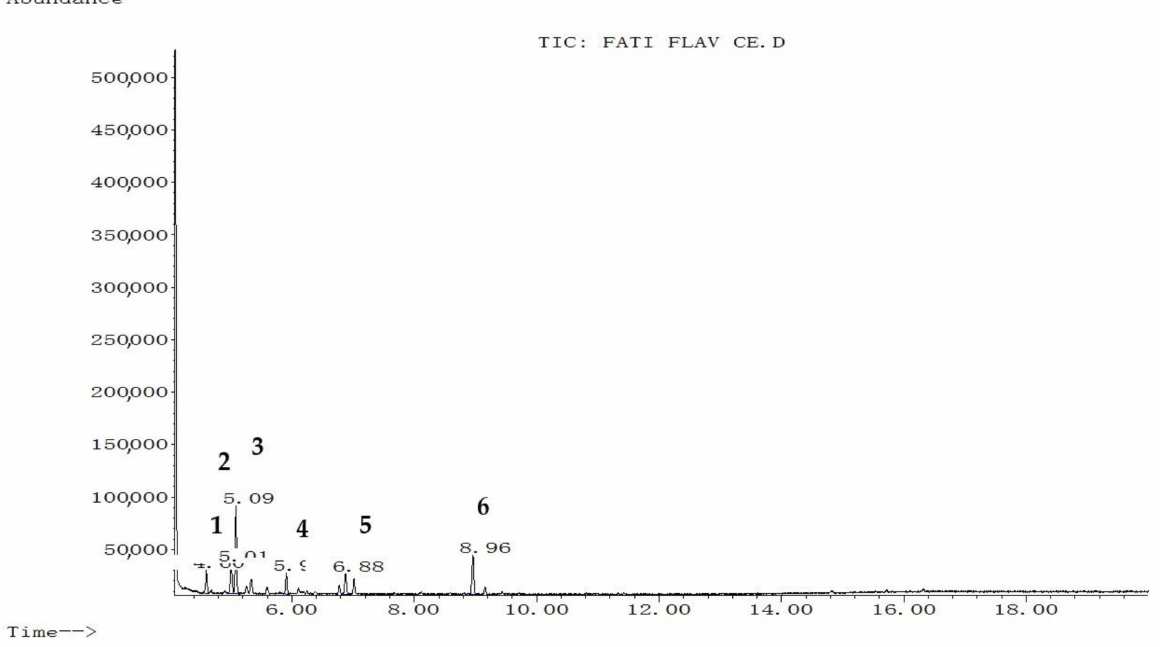
Figure 2. Chromatographic profile of the polyphenol-rich fraction of C. europaea after silylation. 1 : Benzoic acid, 4-methyl-2- trimethylsilyloxy-, trimethylsilyl ester; 2 : Phenol4-(3,4-dihydro-2,2,4-trimethyl-2H-1-benzopyran-4-yl); 3 : Cinnamic acid; 4 : Flavone, 2 ′ -methoxy-; 5 : Butyric acid; 6 : p-coumaryl alcohol.